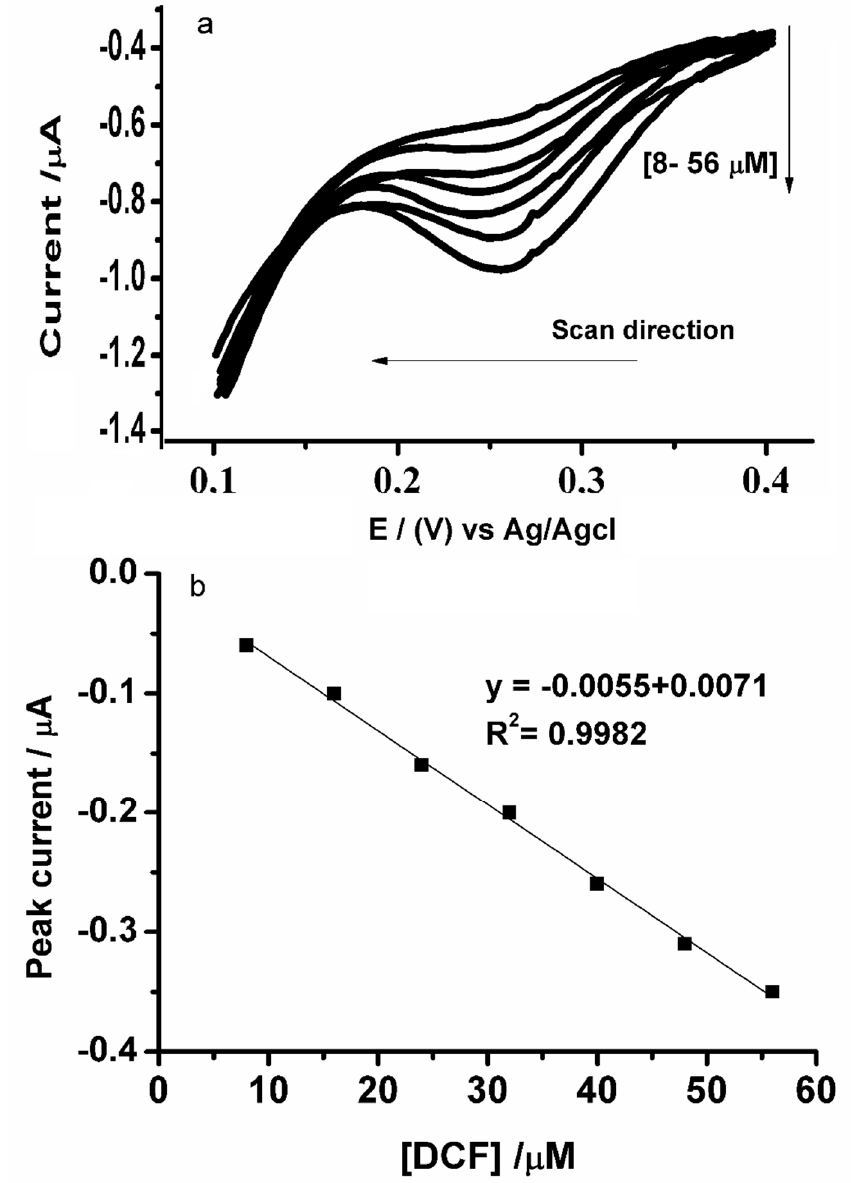
Figure 6. ( a ) DPV of different concentrations of DCF (as arrow indicated) (8, 16, 24, 32, 40, 48, and 56 µM) at the water/1,6-DCH micro-interface. ( b ) Calibration curve for DCF (cid:2879) ion